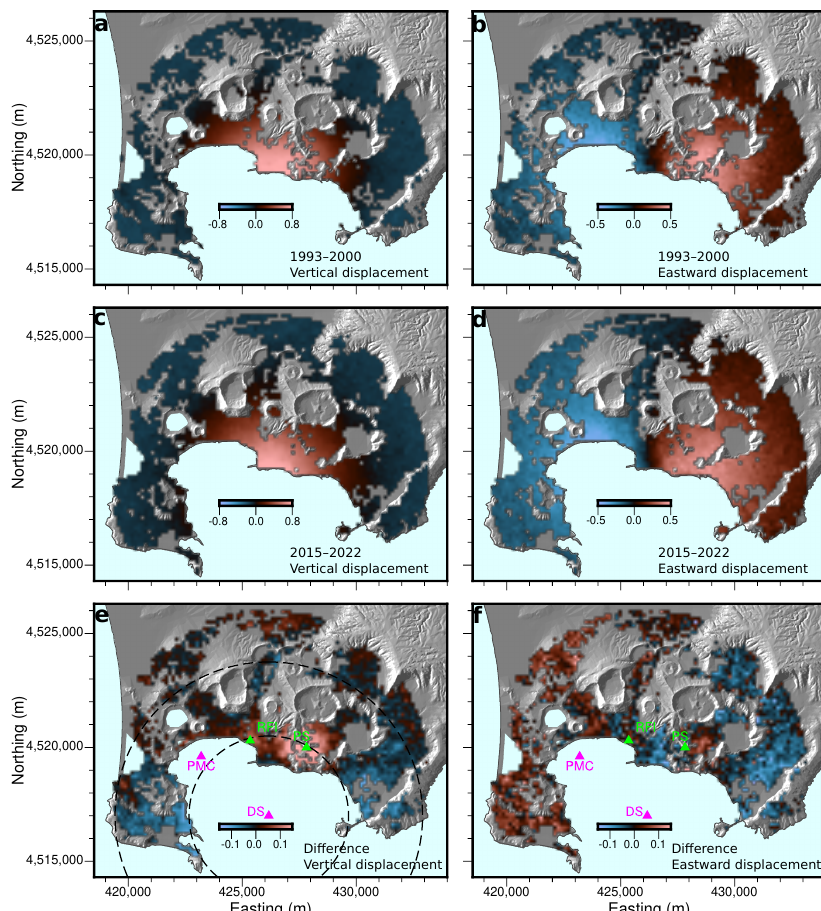
Figure 7. Spatial patterns of the first mode from the joint EOF analysis of vertical and eastward displacements. Vertical and eastward EOFs are normalized by the range of variability (difference of the maximum and minimum values) of the vertical EOF for each time period (1993–2000 and 2015–2022), see Section 2.4. ( a ) ERS/ENVISAT data, vertical displacement (˜ h v in Equation (2)); 1 ( b ) ERS/ENVISAT data, eastward displacement (˜ h e in Equation (2)); ( c ) Sentinel-1A data, vertical 1 displacement (˜ h v in Equation (2)); ( d ) Sentinel-1A data, eastward displacement (˜ h e in Equation (2)); 2 2 − ˜ h v − ˜ h e ( e ) difference of values in ( a , c ) (˜ h v in Equation (3)); ( f ) difference of values in ( b , d ) (˜ h e in 2 2 1 1 Equation (3)). Green and magenta triangles and labels in panels ( e , f ) correspond to the positions of the DS, PMC, RFI and PS. Color palette and range in ( e , f ) have been chosen so to enhance visibility of the pattern differences between 1993–2000 and